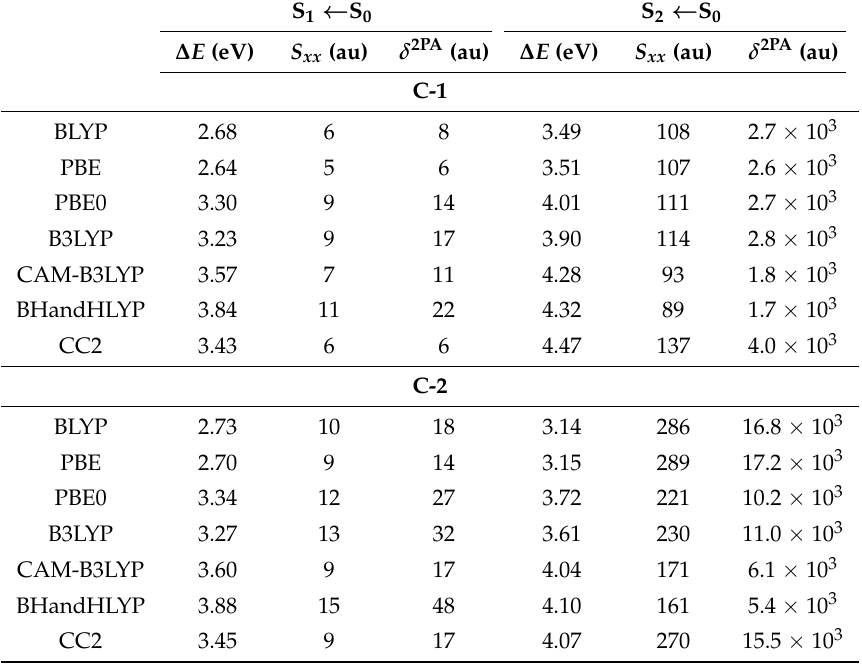
Table 1. Excitation energy ( ∆ E ), the longitudinal element of second-order transition moment ( S xx ) and the two-photon transition strength ( (cid:104) δ 2PA (cid:105) ) for the two lowest-energy excited states of C-1 and C-2 . All calculations were performed with the cc-pVTZ basis set for geometries optimized at the B3LYP/6-311++G(d,p) level of theory. The orientation of molecules in the Cartesian coordinate system is shown in Figure 1.